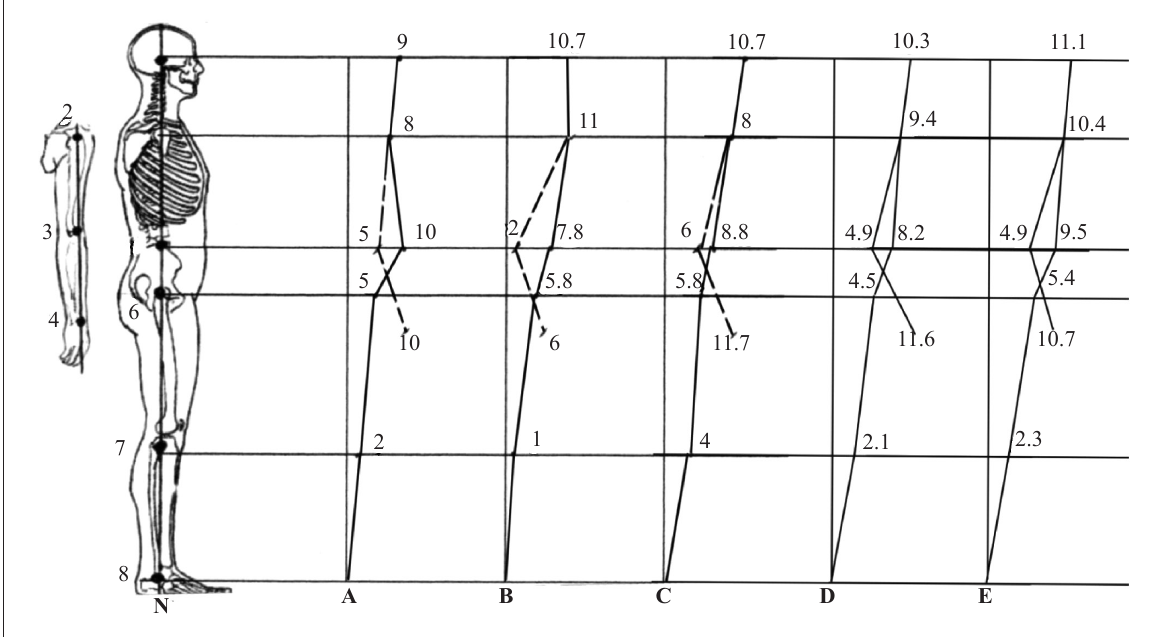
Figure 1. Deviations of the body vertical line from the side, vertical line parameters in cm